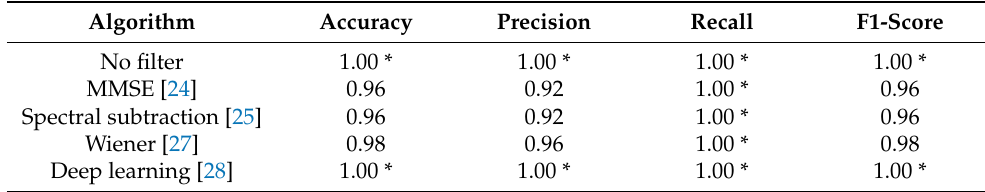
Table 8. White Noise SNR 0. * is the best result for each particular measure.